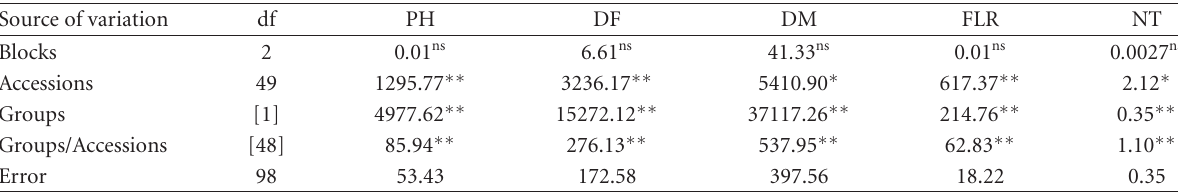
(a) Mean squares of analysis of variance for 5 traits among 50 accessions of upland rice.